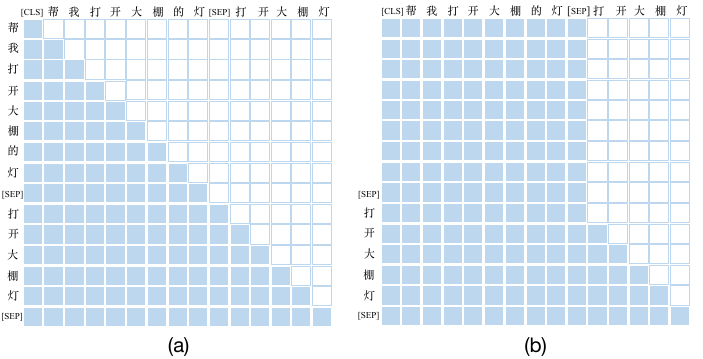
Figure 11. ( a ) Attention mechanism matrix for lower delta masks. ( b ) Attention mechanism matrix for special masking